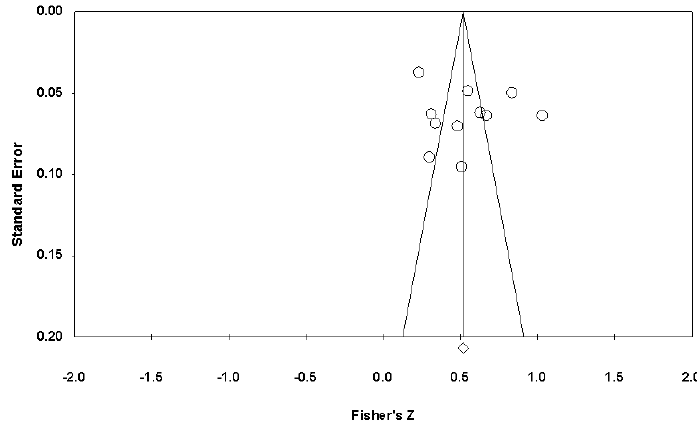
Figure 3. Funnel Diagram of Research on the Search Depth of Green Resources.